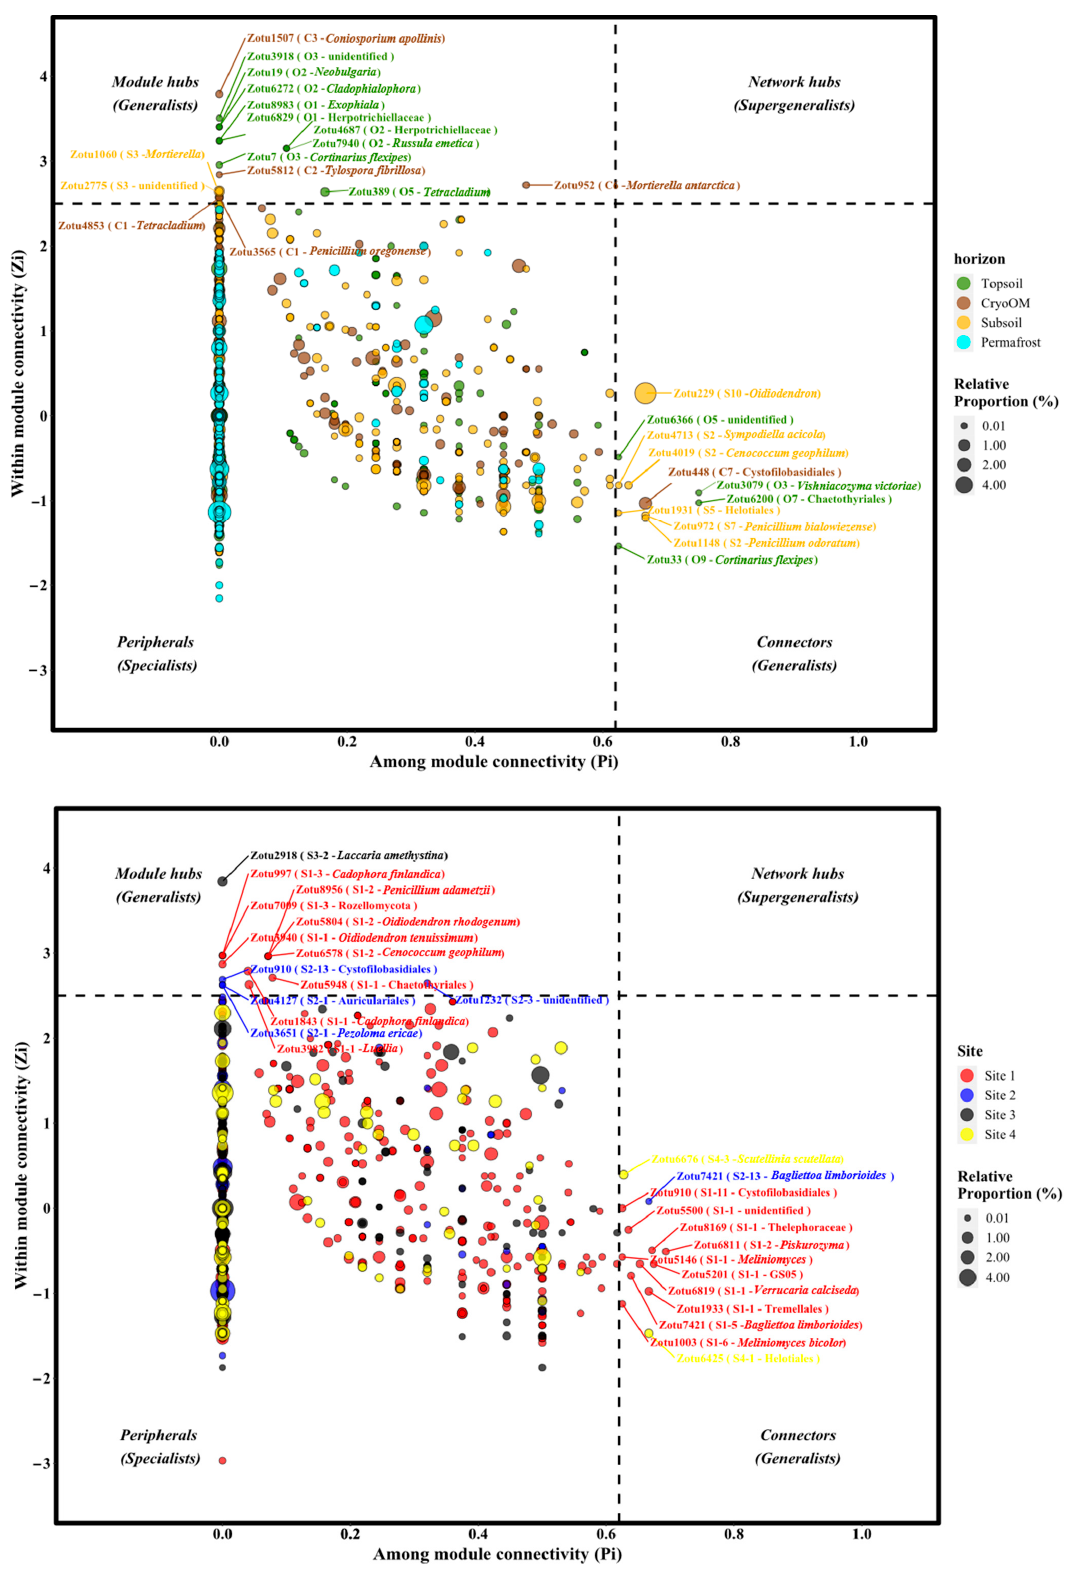
Figure 5. Zi-Pi plot showing topological roles of nodes in different horizons and tundra sites. The threshold values of Zi and Pi for categorizing nodes were 2.5 and 0.62, respectively. Generalists (connectors and module hubs) were labeled with zOTU IDs, module number, and maximum assigned taxonomy (bolded letters). Generalists were colored according to horizons and tundra sites and the size of each node represented the abundance of that node.